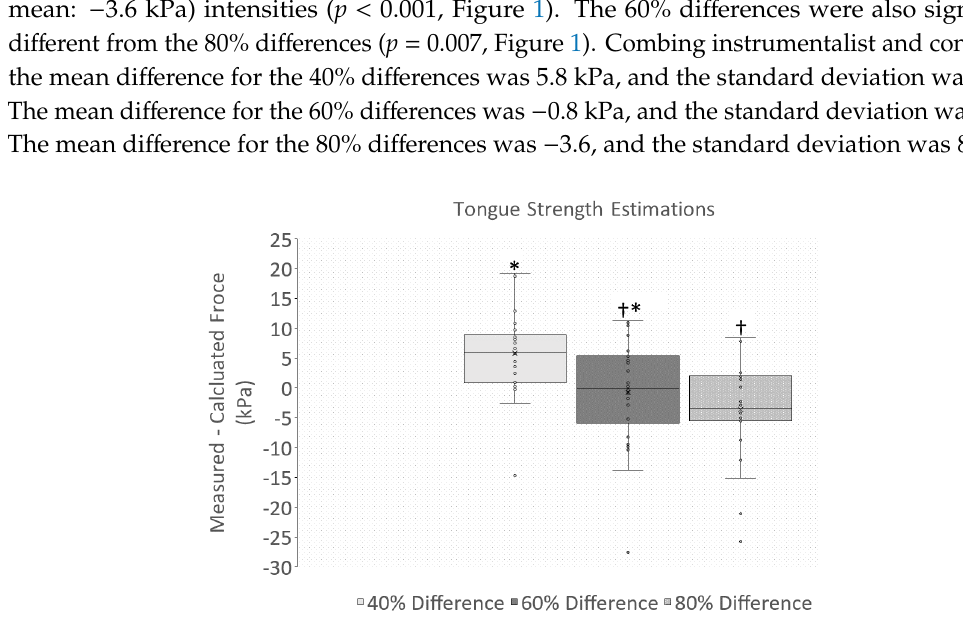
Table 1. Tongue and lip estimated intensities. † p < 0.05 compared to the 40% differences for condition main effect. * p < 0.05 compared to the 80% differences for condition main effect.